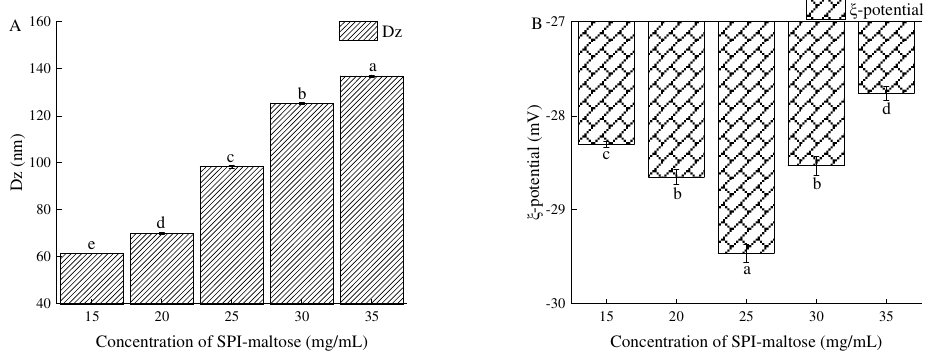
Figure 1. Dz and ξ -potential of different concentration of SPI–maltose. ( A ) shows the particle Figure 1. Dz and ξ-potential of different concentration of SPI–maltose. ( A ) shows the particle size, size, and ( B ) shows the potential. Different letters (a–e) indicate statistically significant differences and ( B ) shows the potential.). Different letters ( a-e ) indicate statistically significant differences ( p ≤ ( p ≤ 0.05), according to ANOVA (one-way) and the Tukey 0.05 ), according to ANOVA (one-way) and the Tukey test.